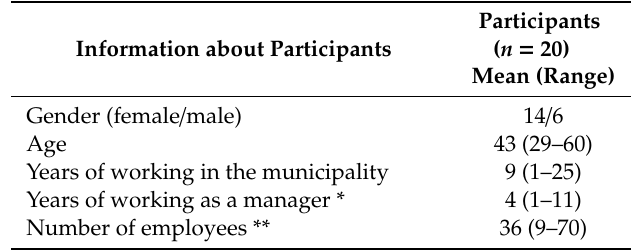
Table 2. Information about Participants.